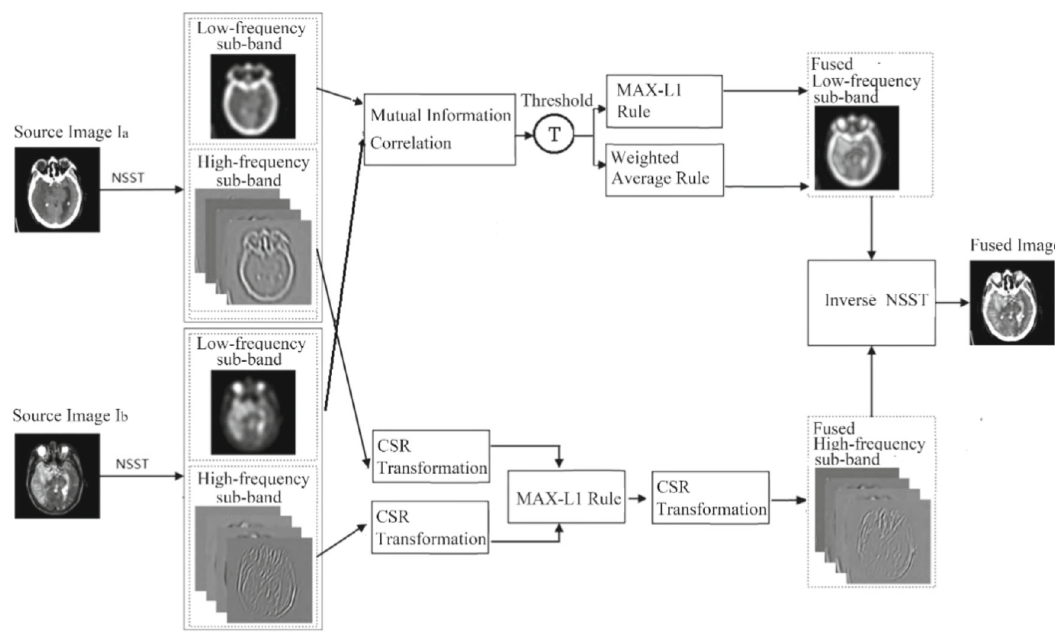
Fig. 2 Multimodal medical image fusion framework based on NSST